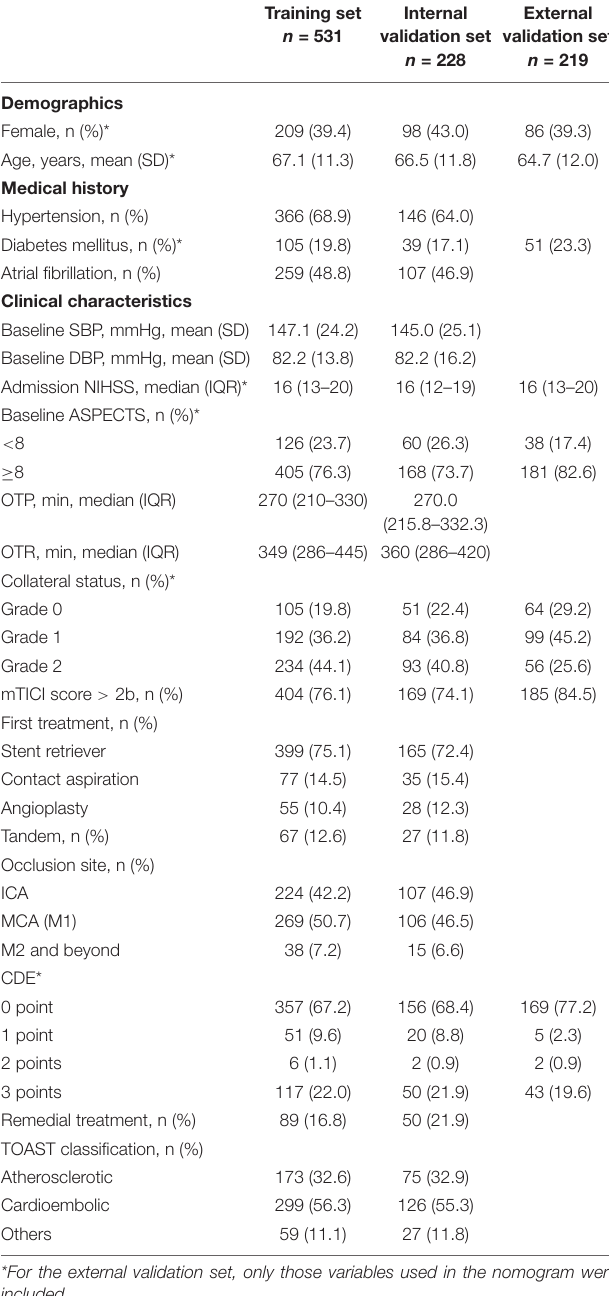
TABLE 1 | Baseline clinical features and radiographic